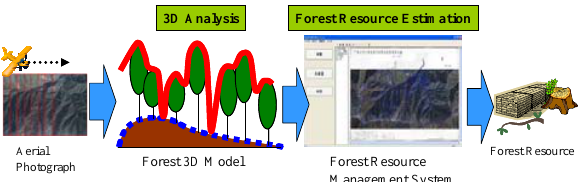
Figure 1. Conceptual Diagram of Forest Resource Management